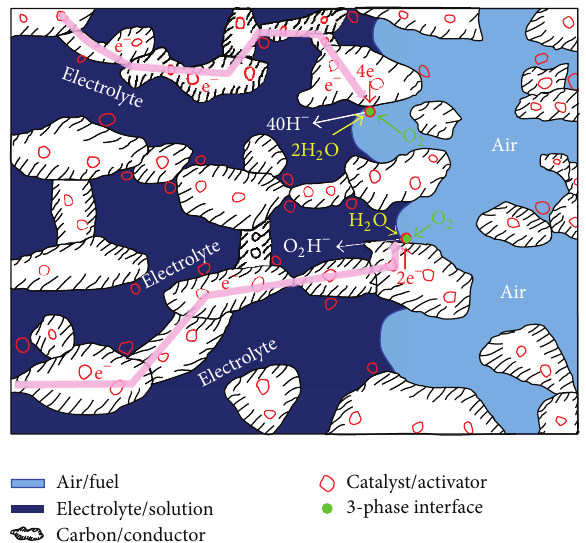
Figure 2: Three-phase interface within catalyst of zinc-air fuel